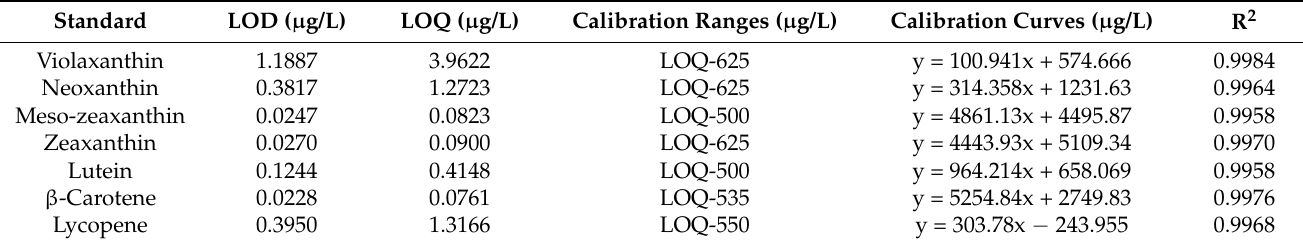
Table 3. Standard analytes used for elaborating the calibration curves with the range used, equations, R 2 , LOD, and LOQ of each compound for the carotenoid